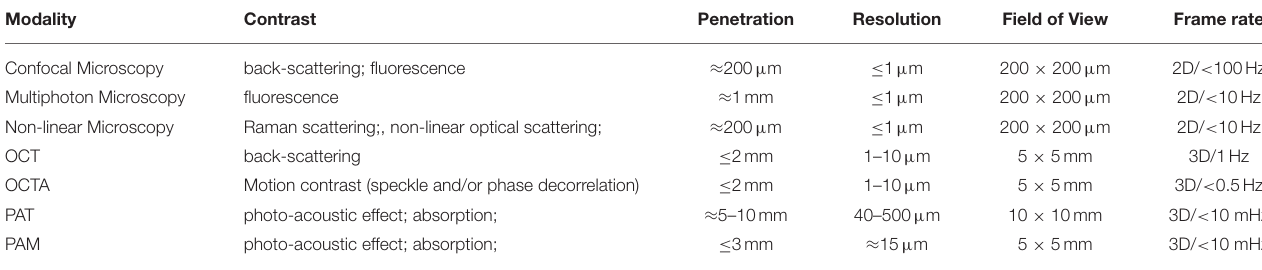
TABLE 2 | Modalities, contrast mechanisms, and imaging parameters.